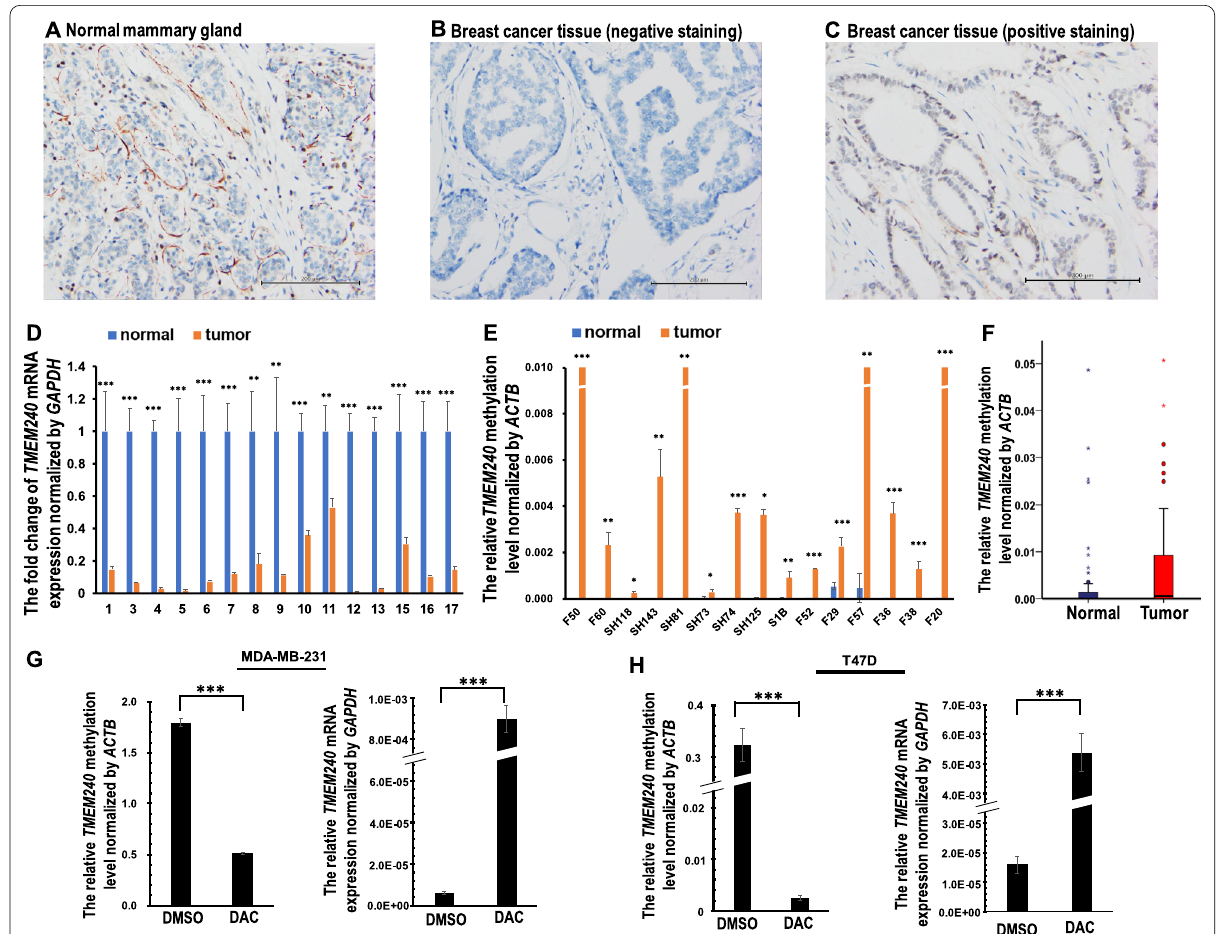
Fig. 3 Low expression of TMEM240 in breast cancer is mediated by promoter methylation. Representative figures showing TMEM240 protein expression as analyzed by IHC. A Normal mammary gland. B Breast cancer tissue with negative expression. C Breast cancer tissue with normal expression (original magnification, 200). The scale bars indicate 200 µm. D , E Representative figure showing the TMEM240 mRNA expression level × ( D ) and TMEM240 promoter hypermethylation as determined by RT–qPCR (E) in adjacent breast normal and tumor tissues. F Box plot of TMEM240 promoter hypermethylation levels in tissues. G , H DNA methylation and mRNA expression were measured after treatment with decitabine (DAC) in MDA‑MB‑231 ( G ) and T47D ( H ) breast cancer cells. The relative DNA methylation levels after treatment with DAC are shown in the left panel. The relative mRNA expression levels after treatment with DAC are shown in the right panel. The data are presented as the mean ***p 0.001. A t‑test was used to calculate group differences in all experiments. The experiments were performed using at least two biological ≤ duplicates and three technical